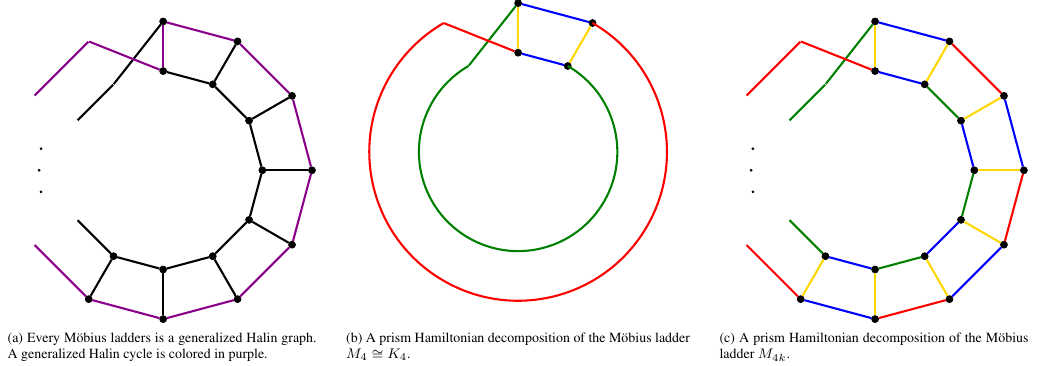
Fig. 12: M ¨ obius ladders are